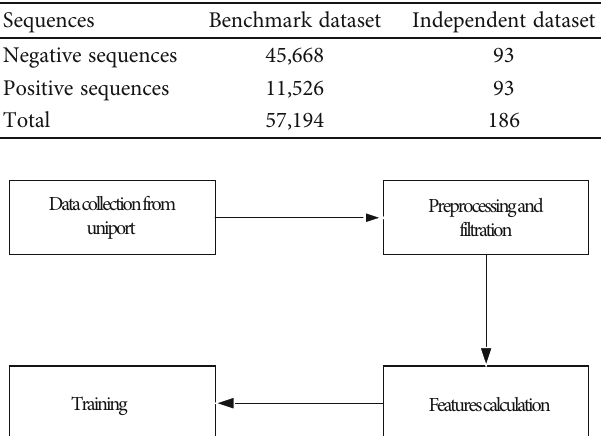
Table 1: Detail of the dataset used.